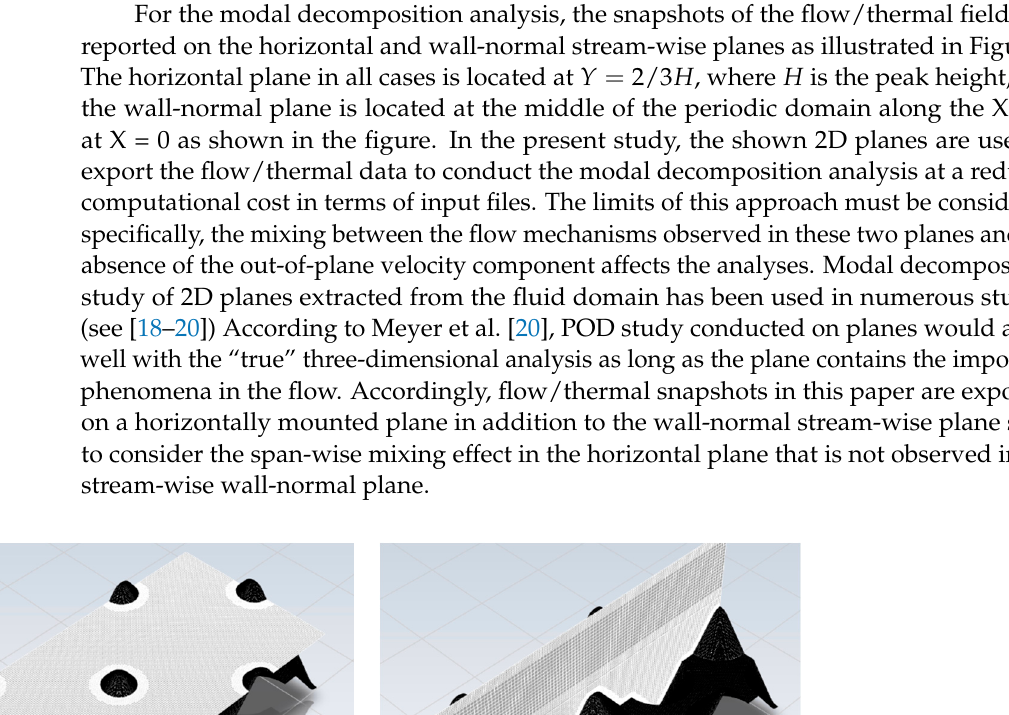
Figure 5. The snapshot planes. ( a ) horizontal and ( b ) stream-wise wall normal planes.